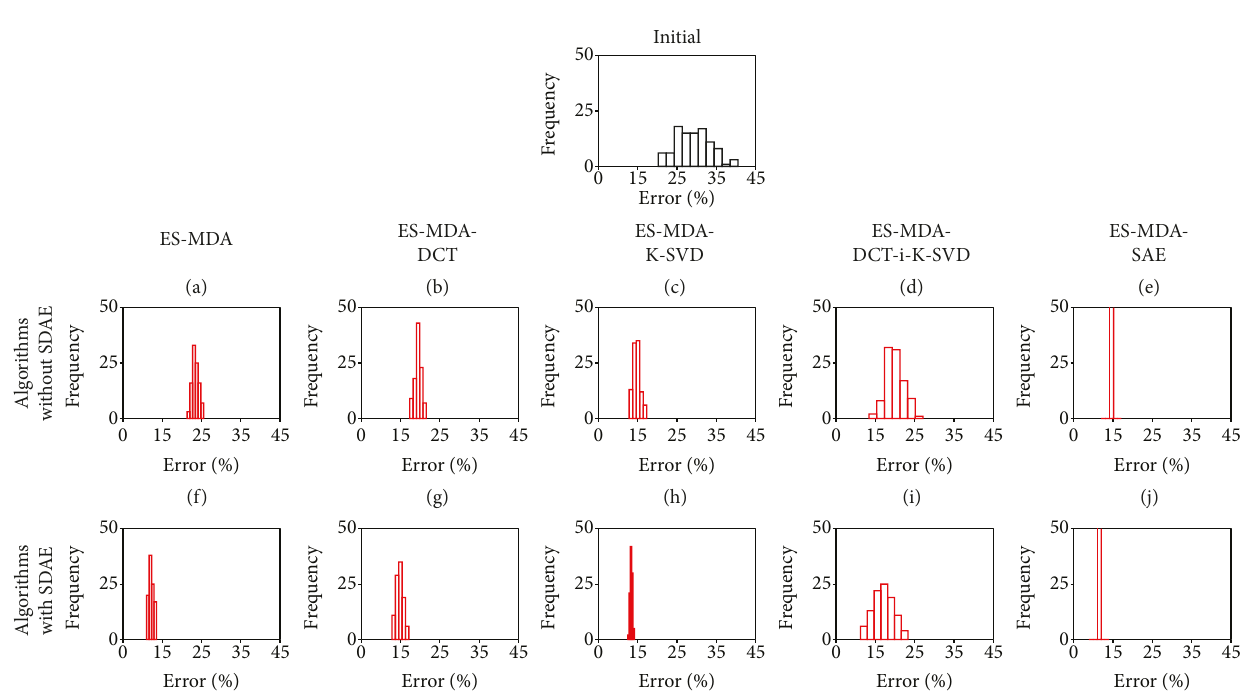
Figure 16: Error histograms for facies distribution of the fi nal ensembles obtained using the ten ES-MDA algorithms.